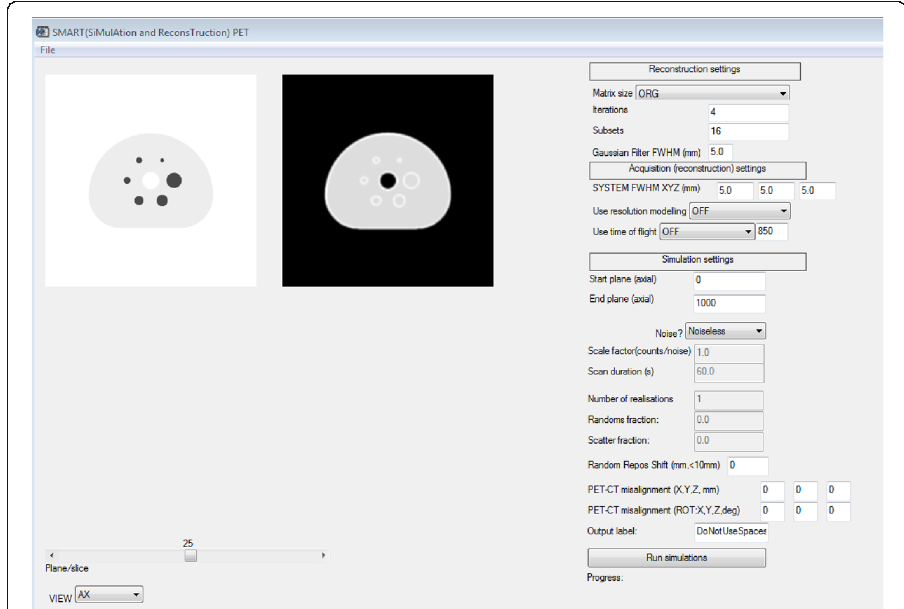
Fig. 1 The SMART-PET GUI. On the upper left, the parameters of the reconstruction can be set, like matrix size, number iterations/subsets, resolution modelling ON/OFF and TOF ON/OFF. On the lower left,